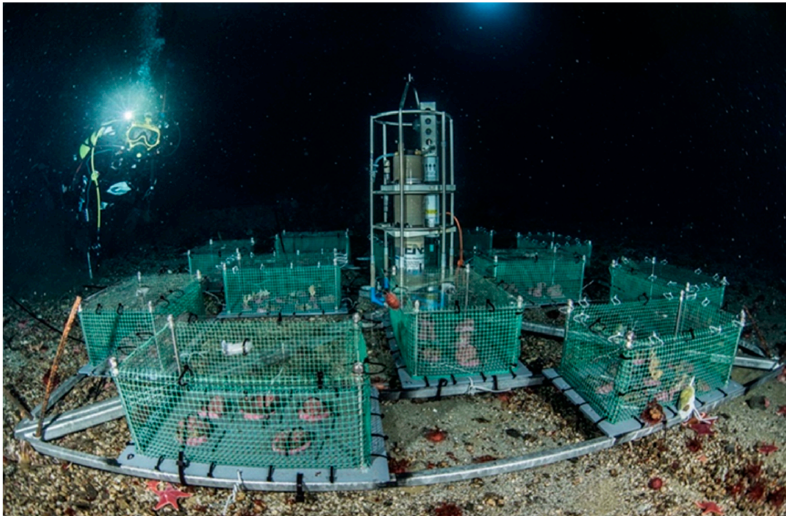
Figure 2. The underwater observatory. The conductivity–temperature–depth (CTD) and pH probes monitoring the seawater parameters were located in the center of the metal frame, whereas the six light-temperature probes were mounted on the plexiglass roof of six different cages containing biological samples (not analyzed in this study). Picture: P. Kuklinski (©